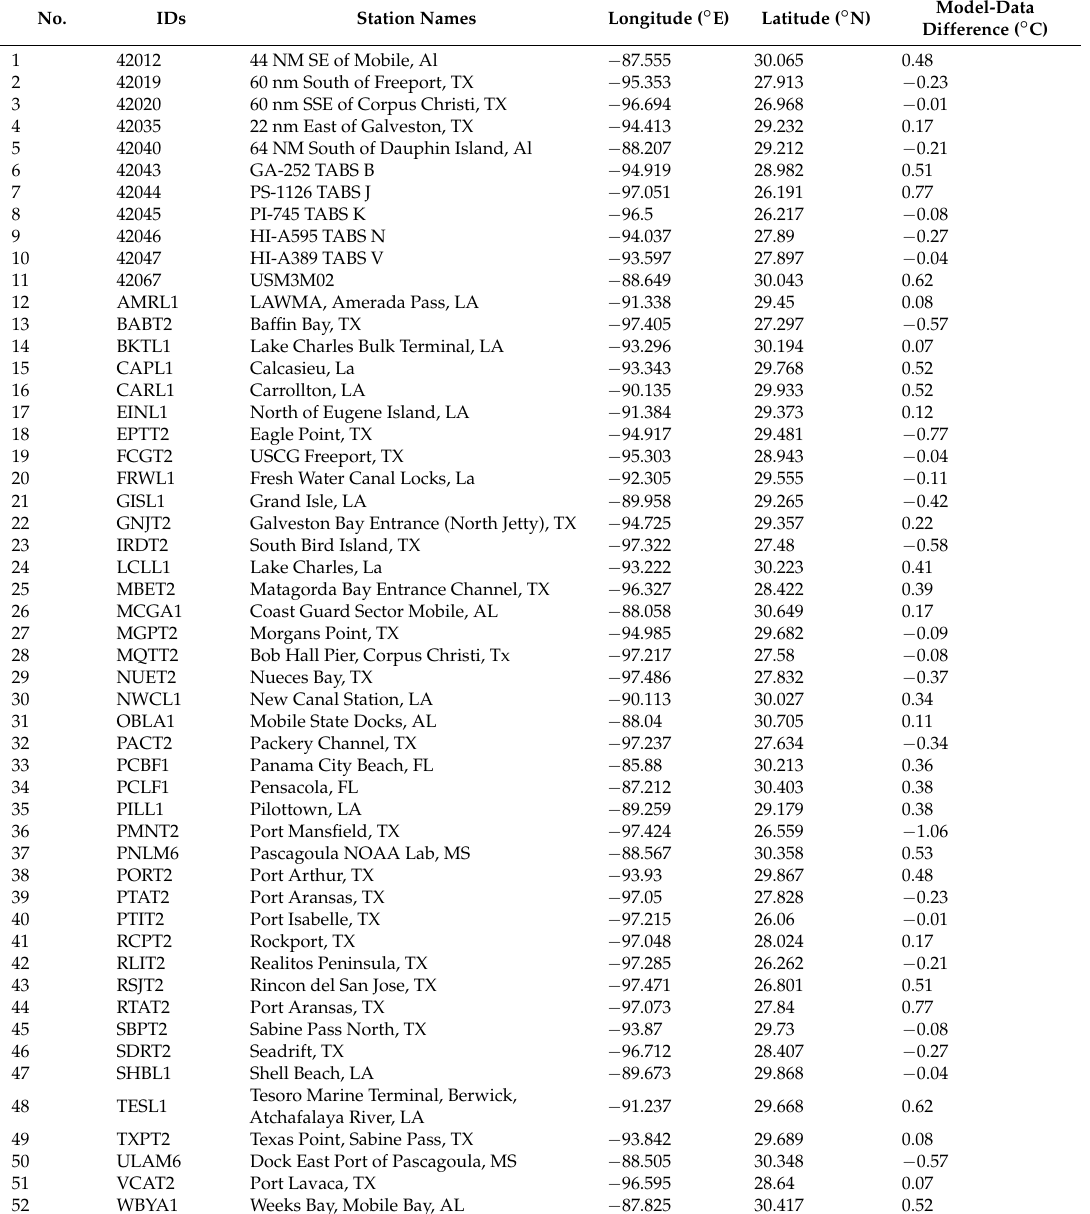
Table A2. Station meta data of water surface temperature